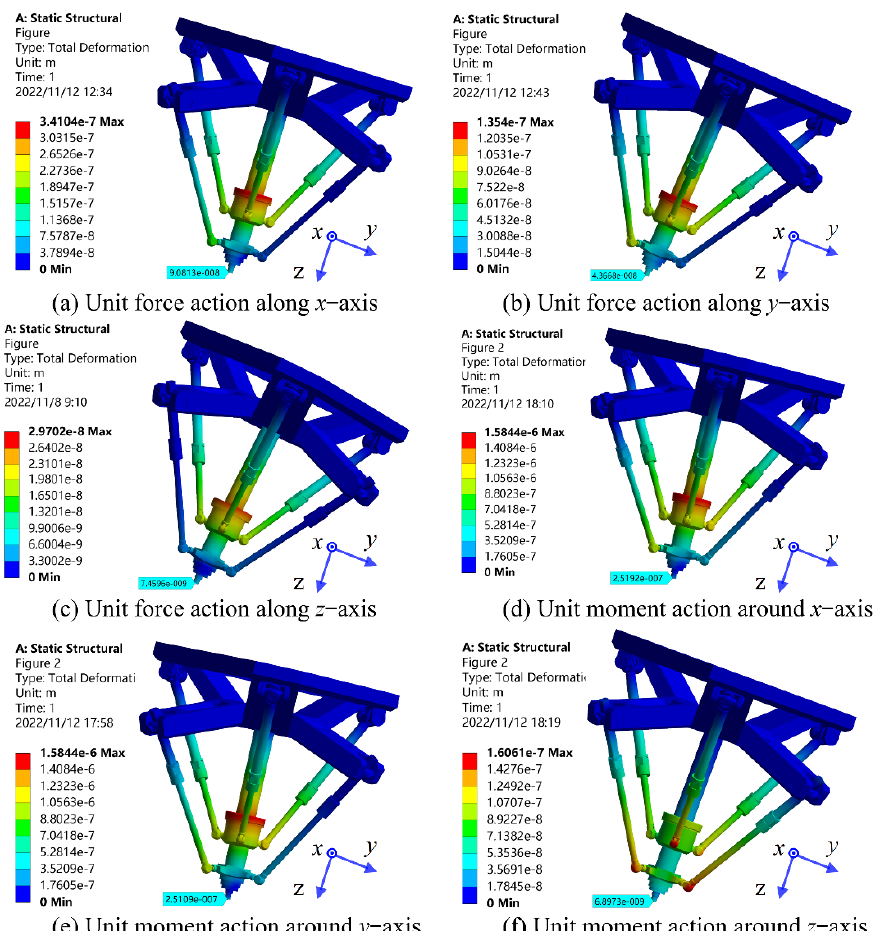
Figure 7. Simulation verification.